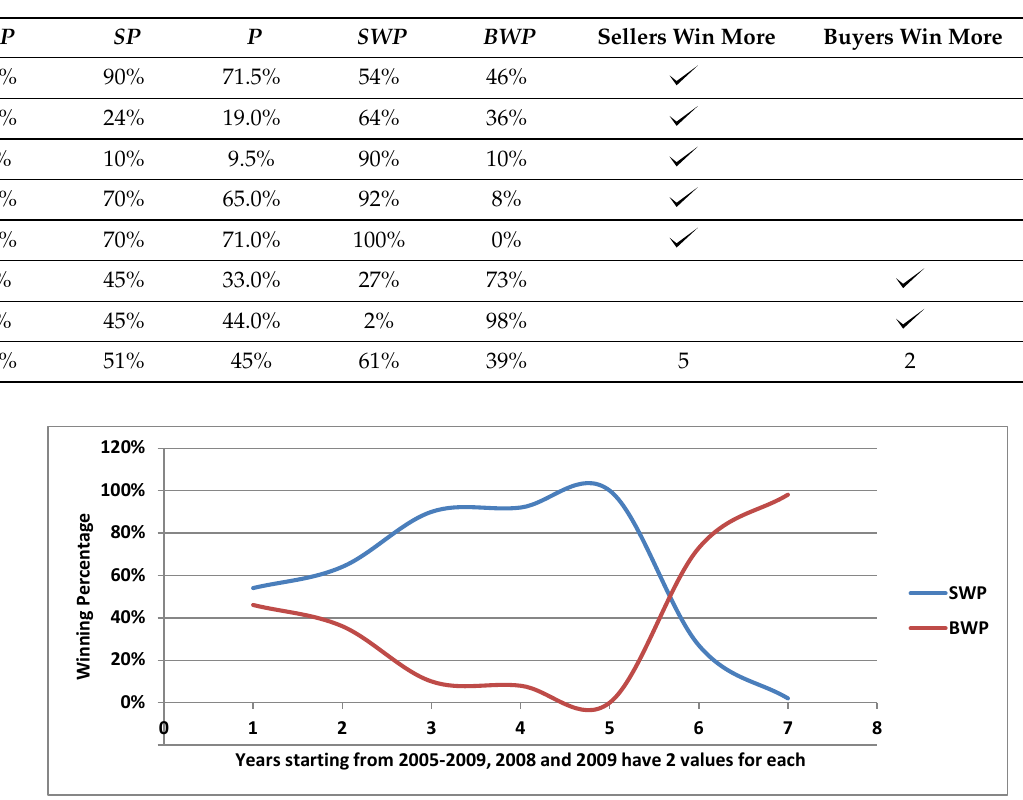
Table 4. Fuzzy win–win results of the international iron ore negotiations (2005–2009).